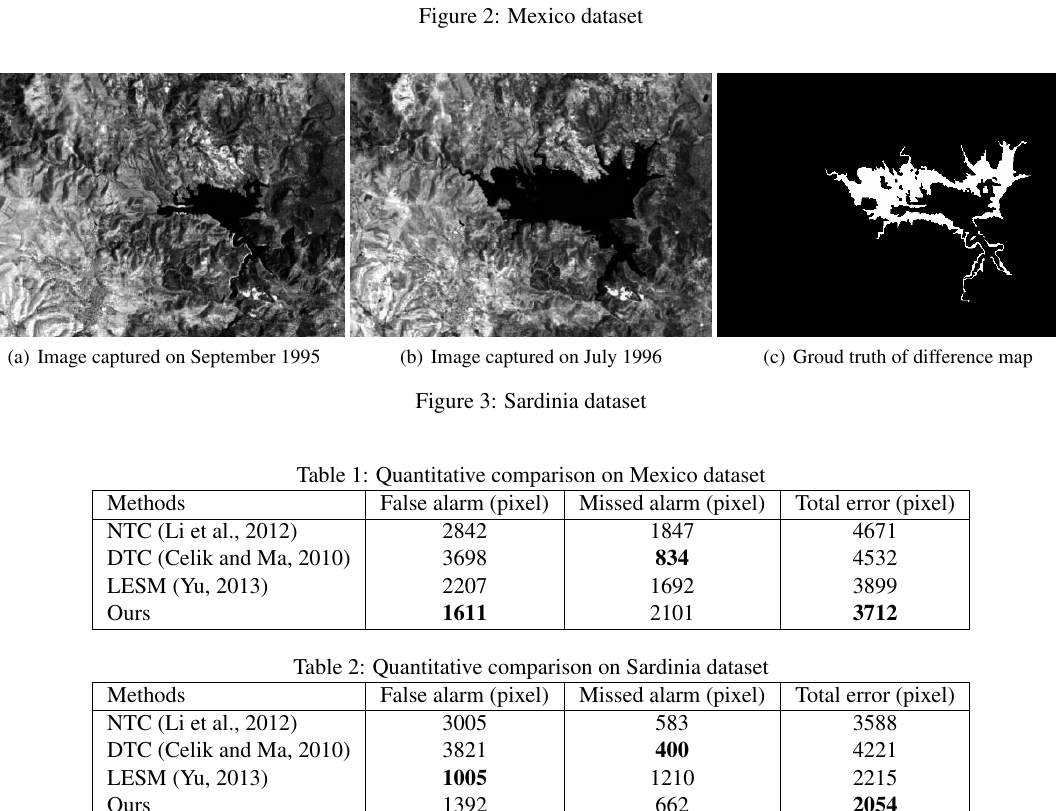
Figure 2: Mexico dataset